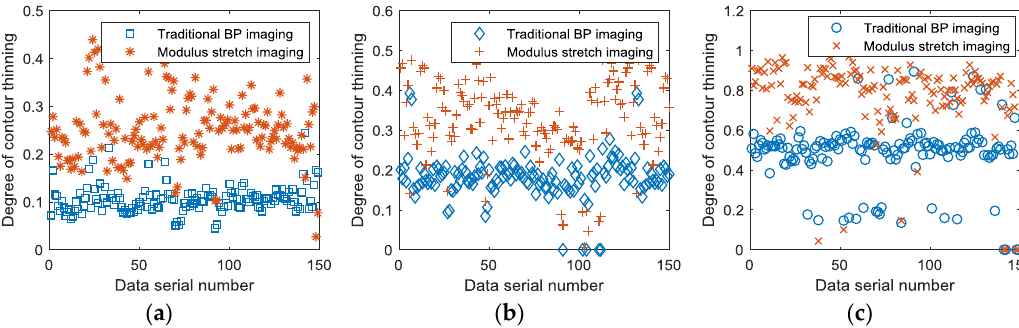
Figure 11. Comparison of contour thinning degree between traditional backprojection imaging and modulus stretch imaging: ( a ) 5° aperture imaging; ( b ) 10° aperture imaging; ( c ) Full aperture imaging.